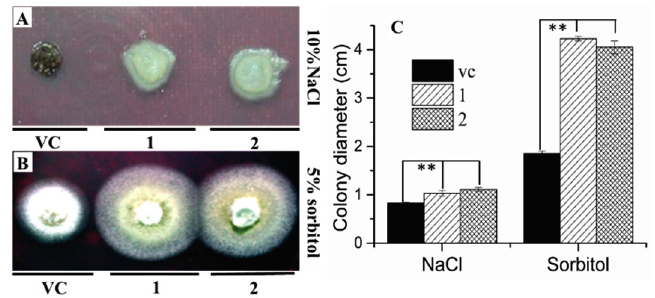
Figure 5. Assay for osmotic stress resistance in AgRPS3aE -transformed M. oryzae . The transformants were incubated on CM containing 10% NaCl ( A ) or 5% sorbitol ( B ) for